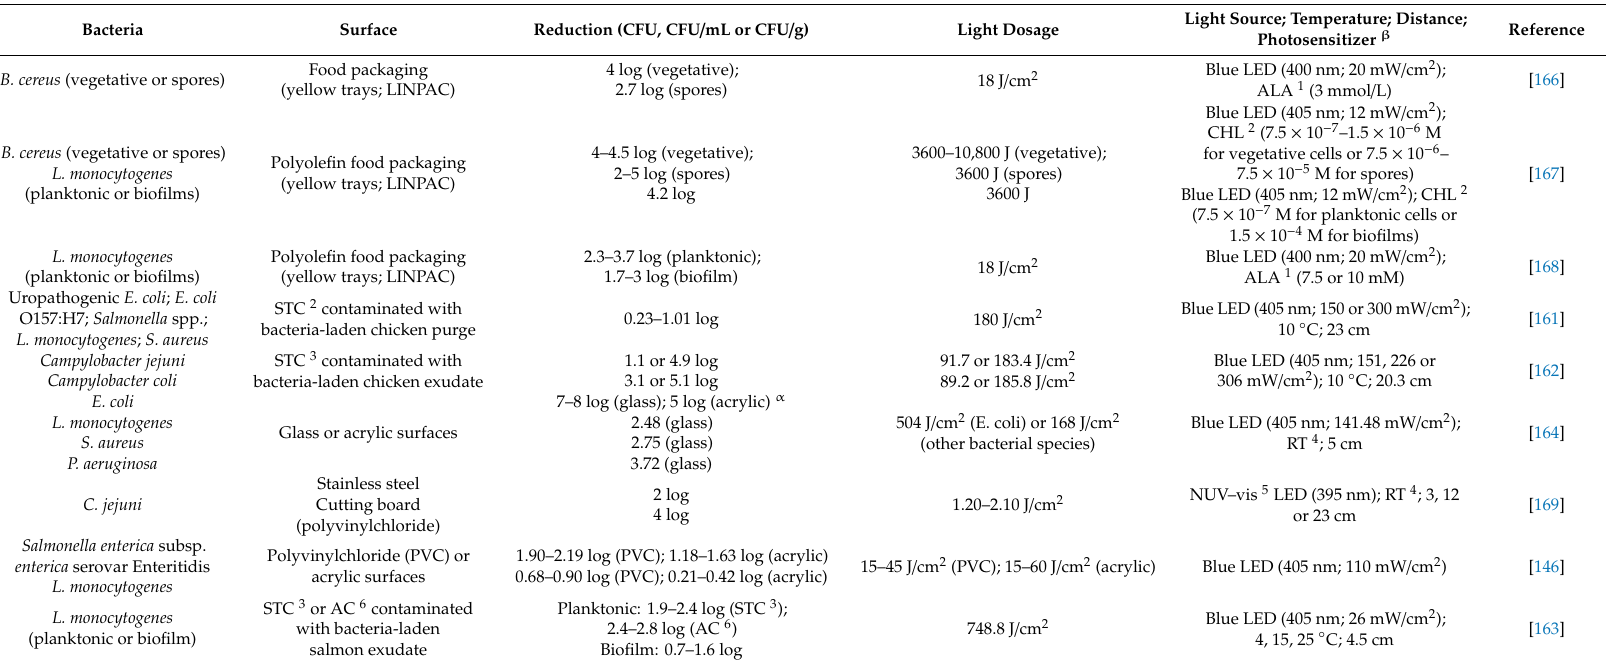
Table 1. Blue light inactivation of pathogenic bacteria on